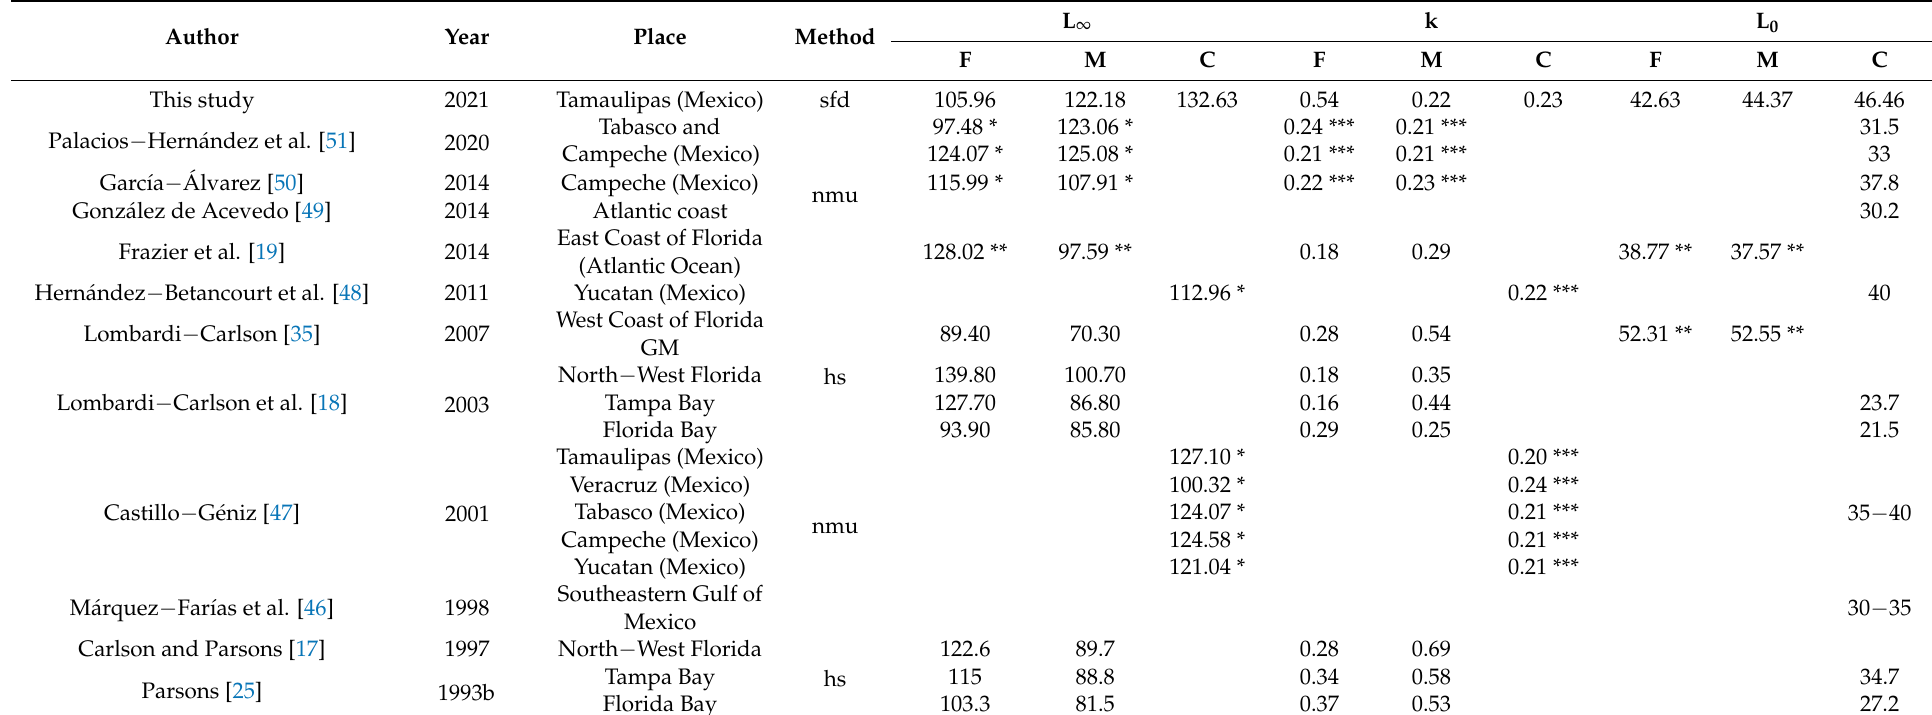
Table 6. Growth parameters (L ∞ , k, and L 0 ) of the bonnethead shark Sphyrna tiburo reported in the